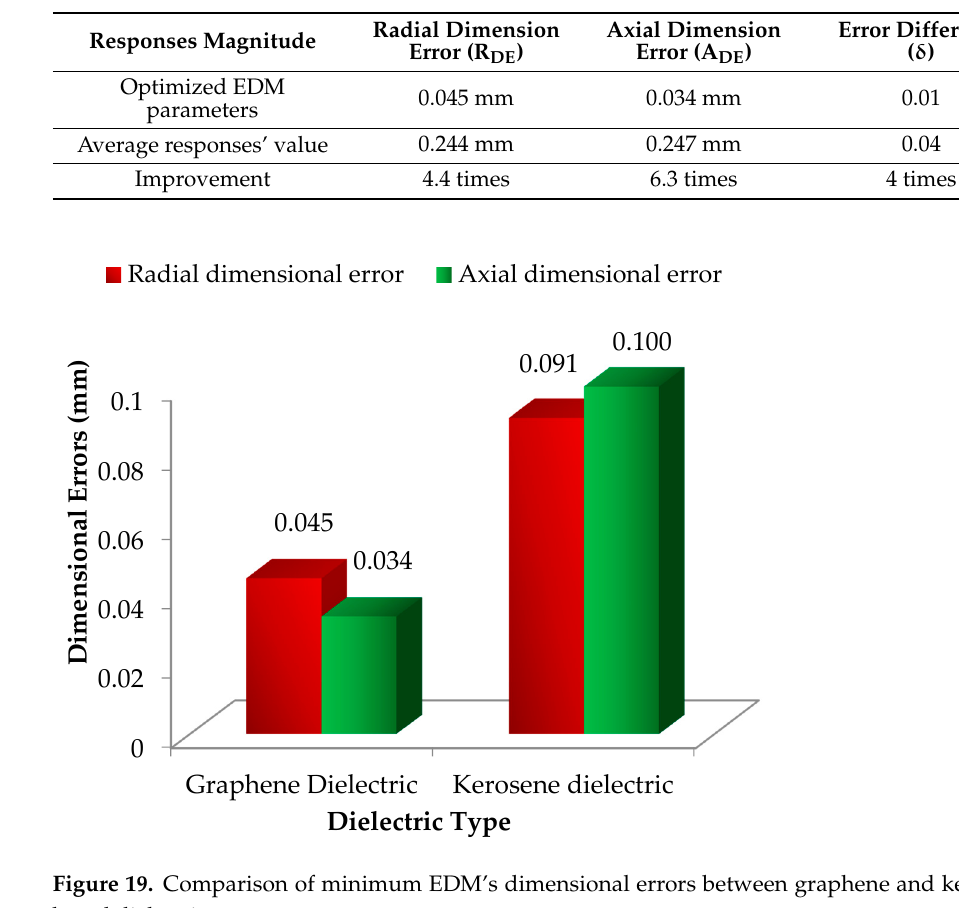
Figure 19. Comparison of minimum EDM’s dimensional errors between graphene and kerosene-based dielectric.